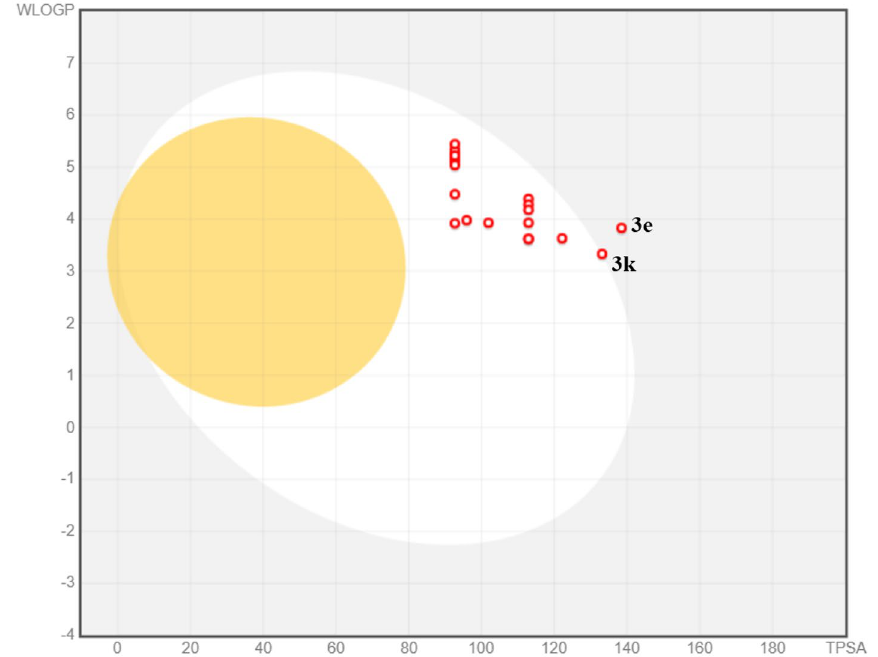
Figure 11. The boiled-egg plot of the synthesized derivatives 3(a–u)